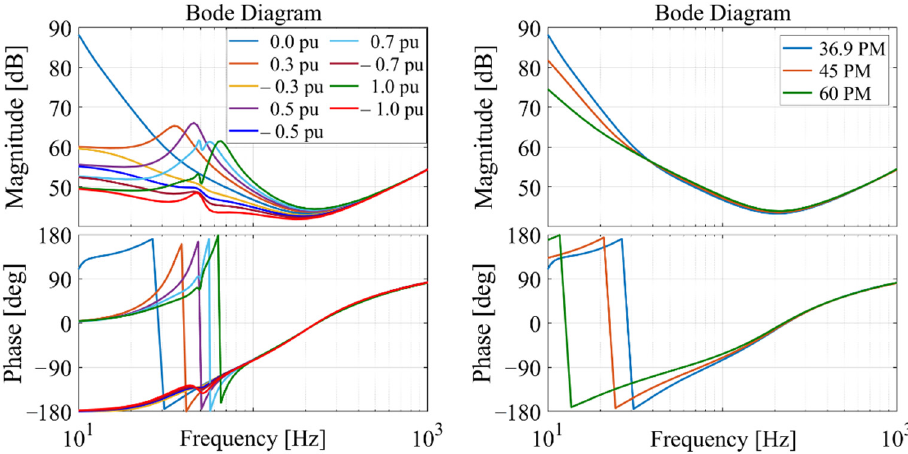
Figure 7. Active power controlling MMC for various working points ( left ) and different control parameters ( right ).